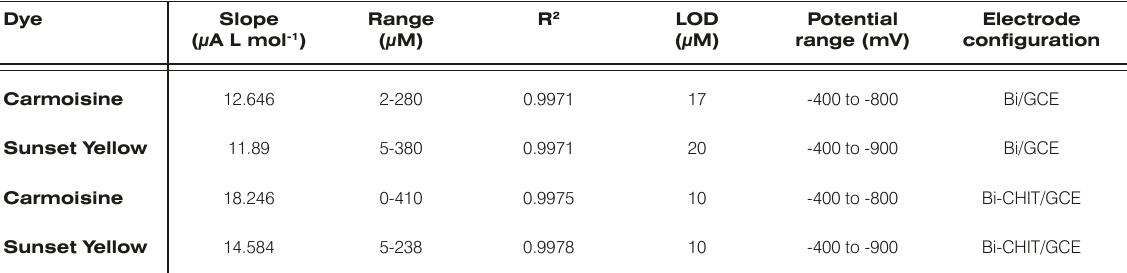
Table 2. Calibration curve values of Carmoisine and Sunset Yellow.